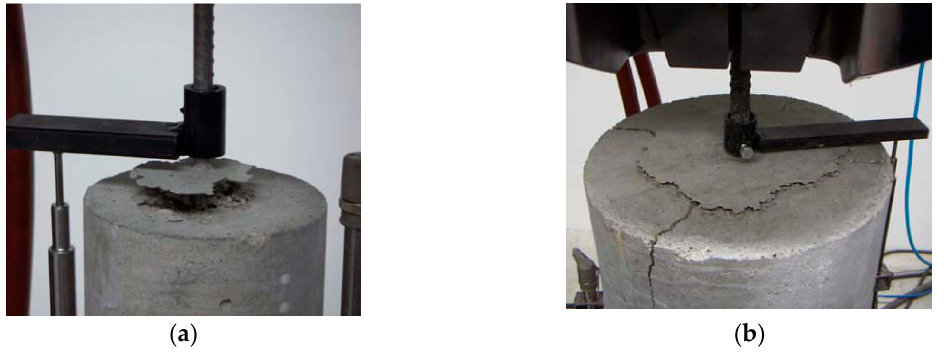
Figure 7. Concrete tensile failure: ( a ) specimen S25; ( b ) specimen S53.